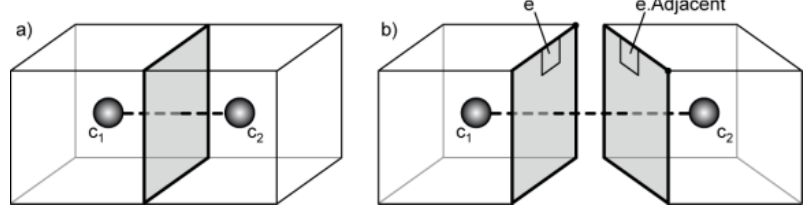
Figure 9. The Adjacent operator: ( a ) the grey face is shared by adjacent cells c 1 and c 2 ; ( b ) the Adjacent operator allows for navigation between cells: from e in c 1 to e.Adjacent in c 2 .